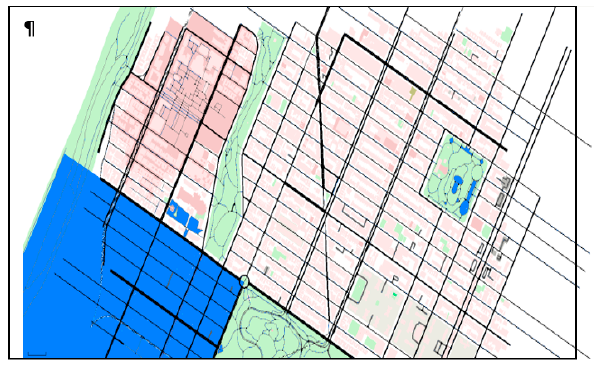
Figure 4. Manhattan city map.